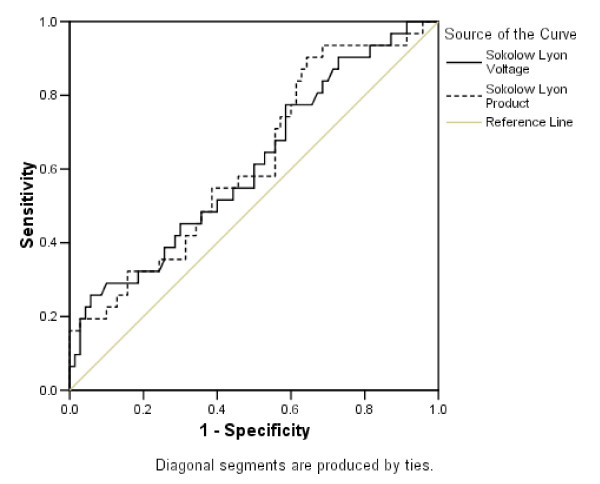
ROC curves with a cut off value of 93 g/m2 for LV hypertrophy.